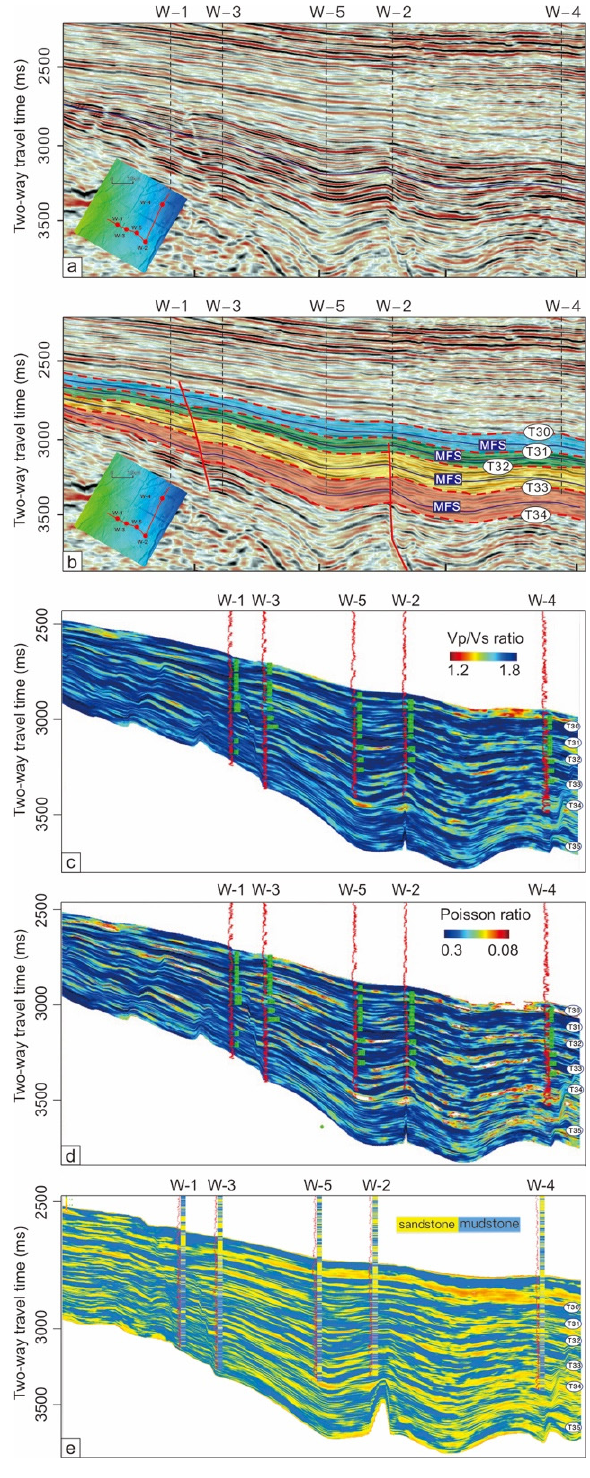
Figure 7. ( a ) The uninterpreted profile; ( b ) interpreted profile; the correlation profile inverted and ( c ) Vp/Vs; ( d ) Poisson’s ratio; and ( e ) sand and mudstone profile of well W-4, W-2, W-5, W-3, an W-1.